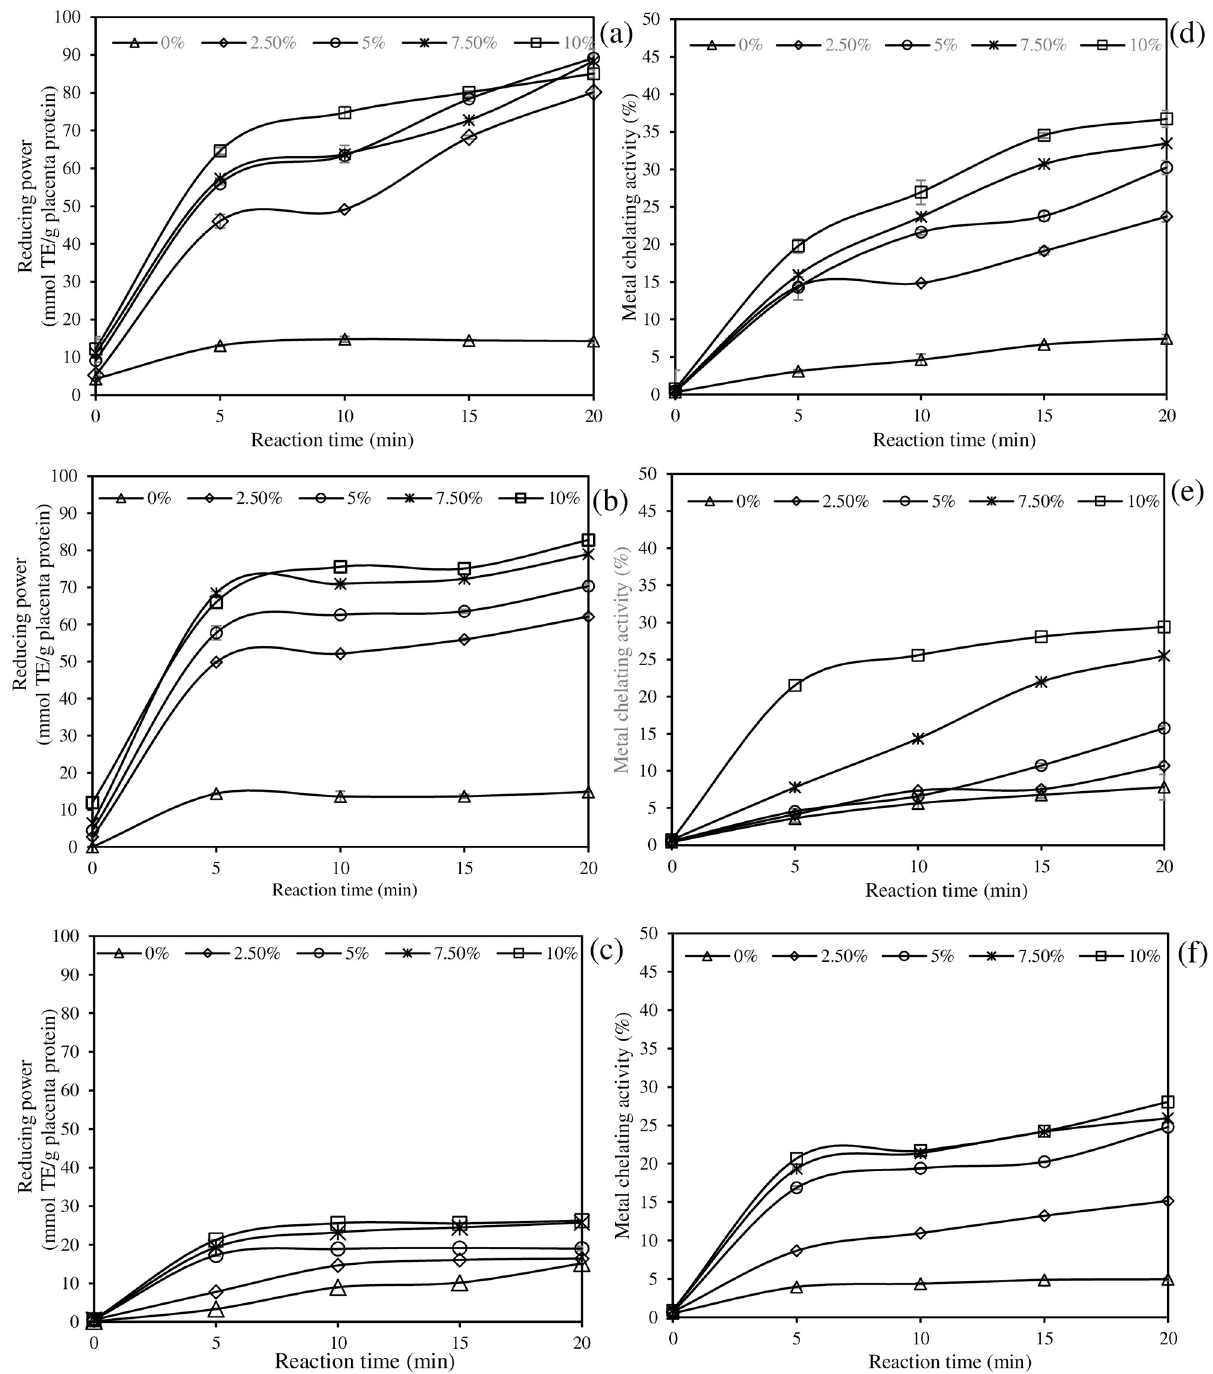
Fig 3. Effects of enzyme type (Alcalase (a, d), Flavourzyme (b, e), and papain (c, f)), enzyme concentration, and hydrolysis time on the reducing power (a, b, c) and metal chelating activity (d, e, f) of porcine placenta hydrolysate (PPH). Bars represent standard deviation from triplicate